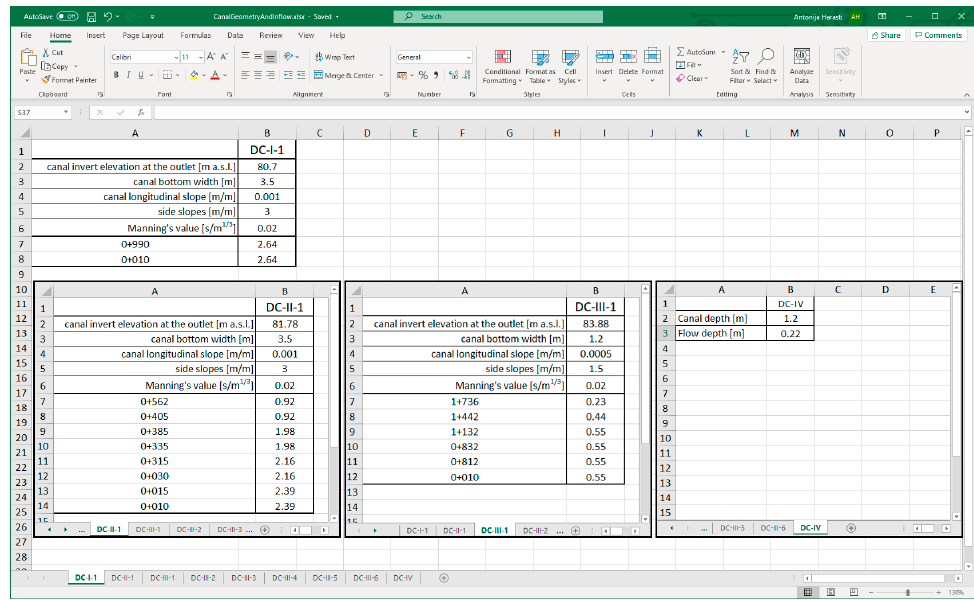
Figure 4. Structure of the CGI input file (separate Excel worksheets are used for each canal in the network).